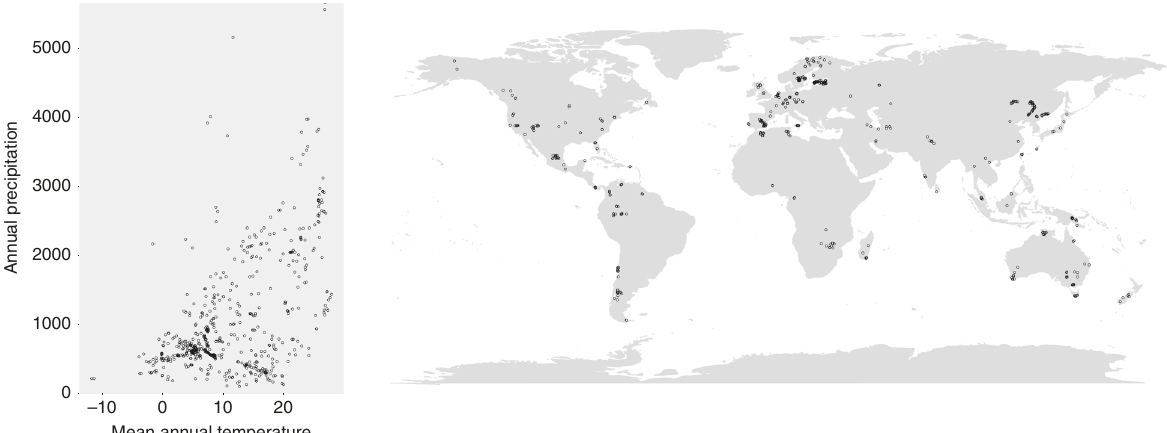
Fig. 1 Mean annual temperature and annual precipitation of the analysed samples and their